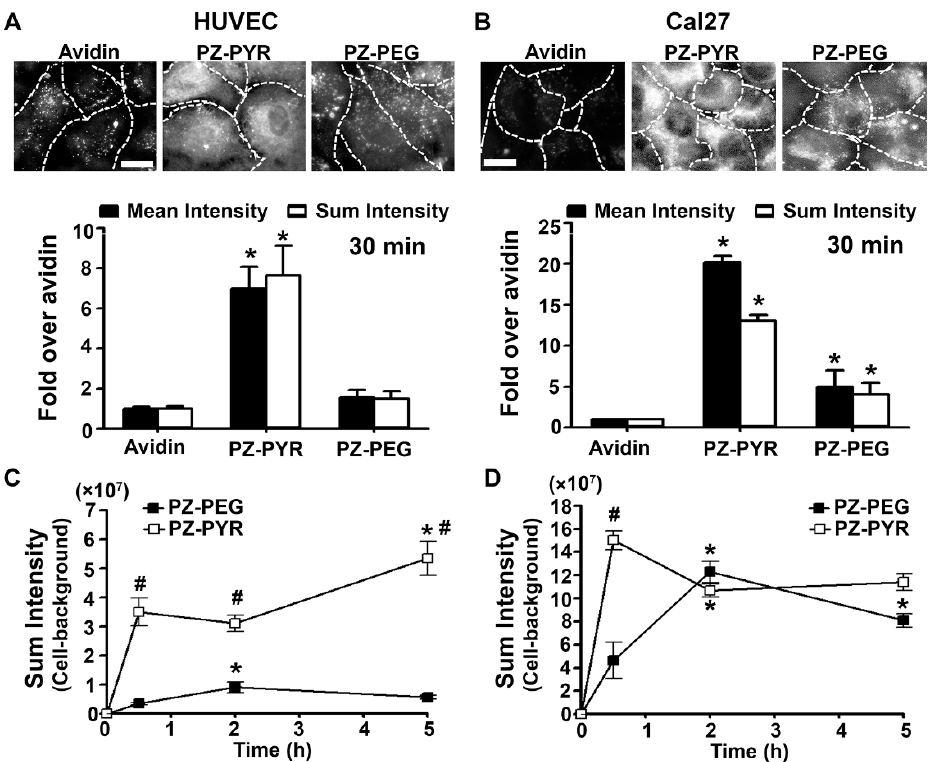
Figure 2. Binding of PZ/protein complexes to different cell types. ( A ) Human Umbilical Vein Endothelial Cells (HUVECs) or ( B ) Cal27 cells, incubated for 30 min at 37 °C with FITC-avidin alone or complexed to PZ-PYR or PZ-PEG. Fluorescence microcopy images (top) and image quantification of the mean intensity and sum intensity (bottom) are shown. Dashed lines = cell borders as seen by bright field. Scale bar = 10 µm. Data are mean ± SEM. * p < 0.05 relative to control avidin. ( C , D ) Similar experiments comparing different incubation times in ( C ) HUVECs or ( D ) Cal27 cells, quantified as fluorescence sum intensity. Data are mean ± SEM. # p < 0.05 relative to PZ-PEG, * p < 0.05 relative to the previous time point.